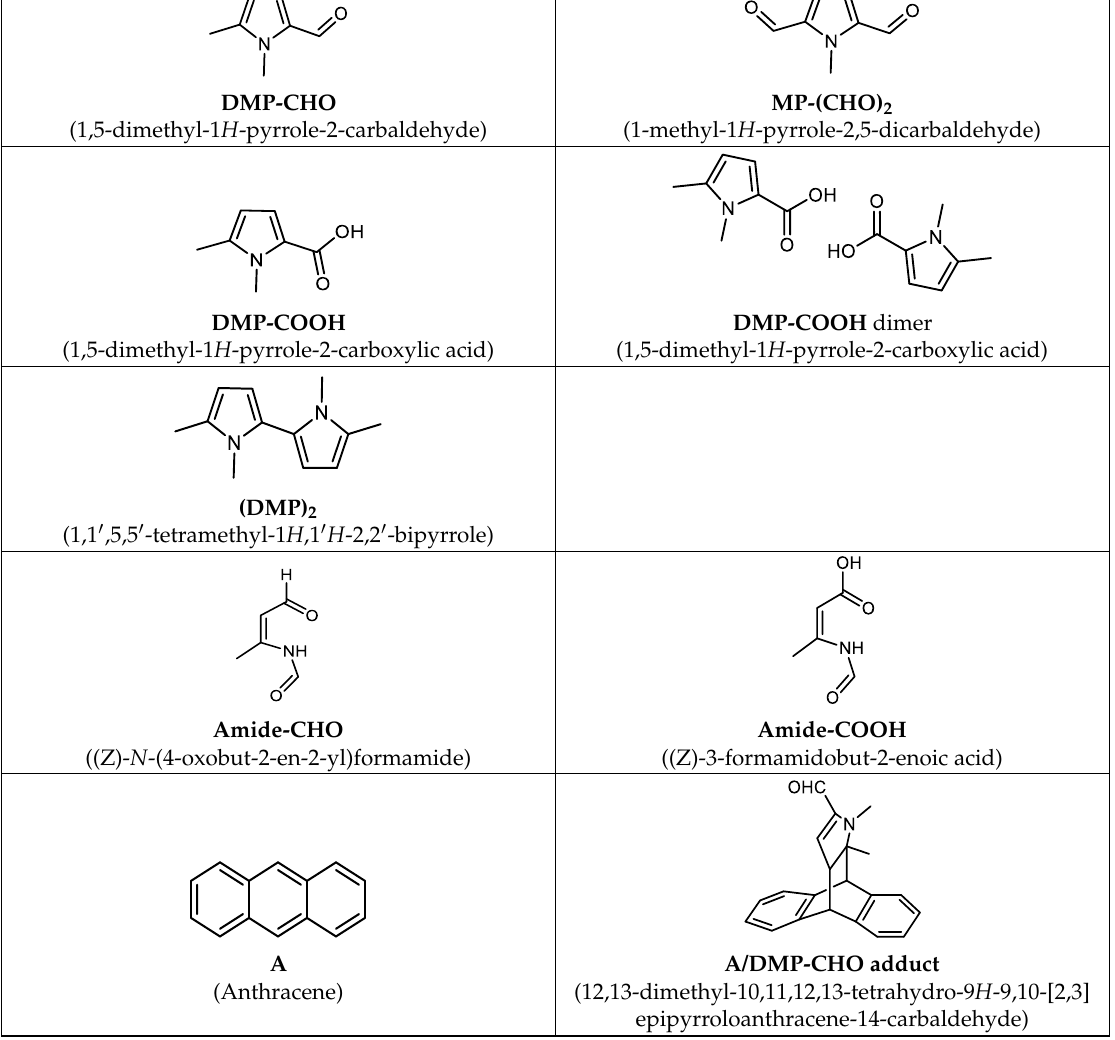
1,5-dimethyl-1 H -pyrrole-2-carbaldehyde, DMP-COOH ( a ), 1-methyl-1 H